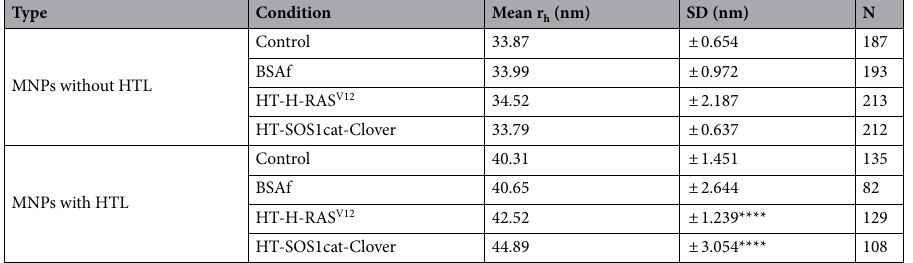
Table 1. Results of MALS to characterize the in vitro binding of HT fusion proteins to HTL-MNPs. For MNPs without HTL, the addition of neither BSAf nor HT fusion proteins changed r h significantly. Due to the presence of PEGylation and HTL, MNPs with HTL had an increased r h compared to MNPs without HTL. Co-incubation with HT fusion proteins resulted in a significant increase of r h that was proportional to the size of the proteins. In contrast, no significant change was detected for MNPs co-incubated with BSAf. ****P ≤ 0.0001, one-way